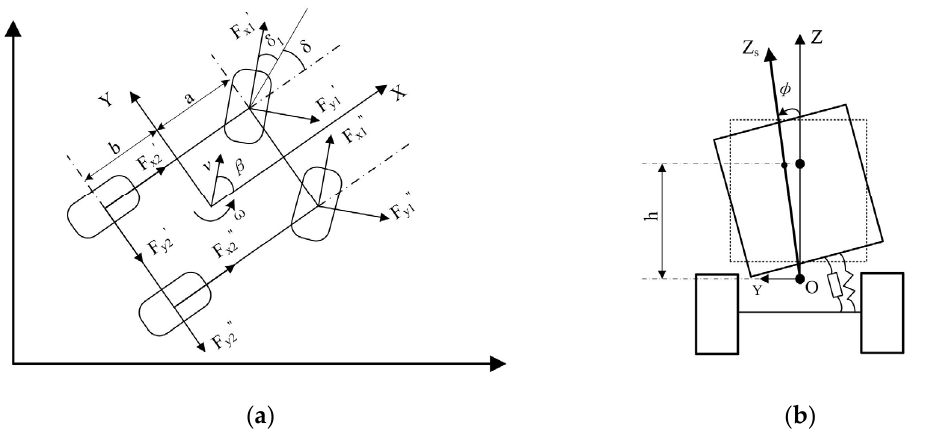
Figure 1. Generalized coordinates of automobile movement. ( a ) Vertical view; ( b ) Rear view.